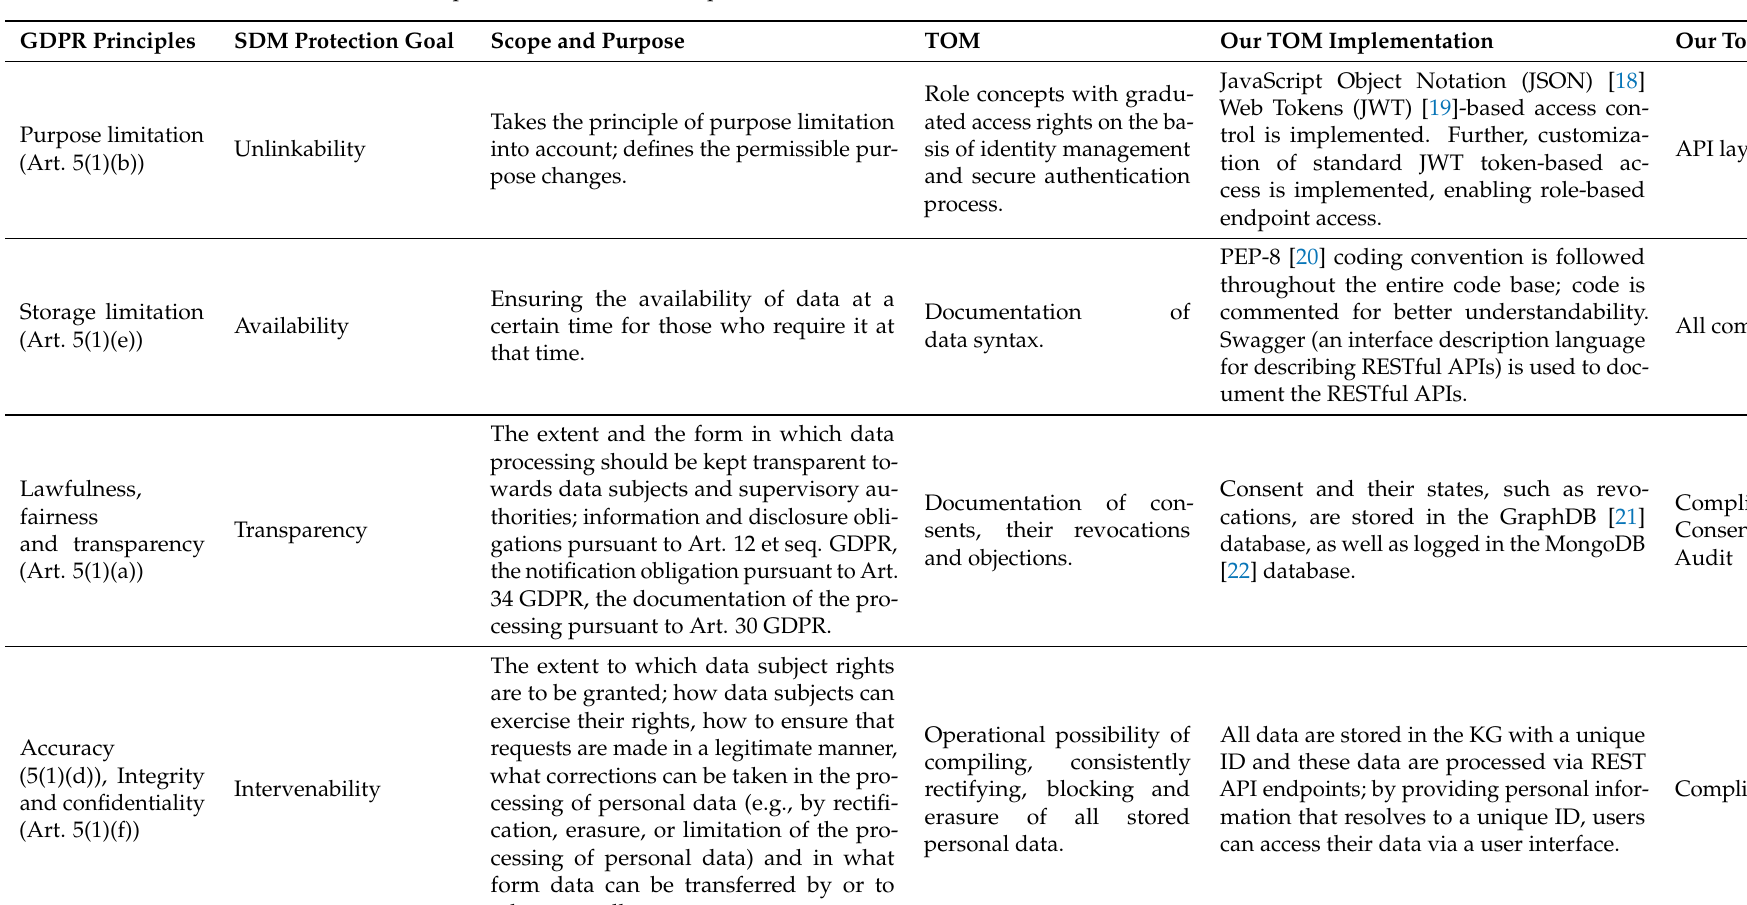
Table 1. GDPR principles and associated SDM protection objectives, their scope and purpose, as well as the associated technical–organizational measures (TOMs) and their implementations in our compliance verification